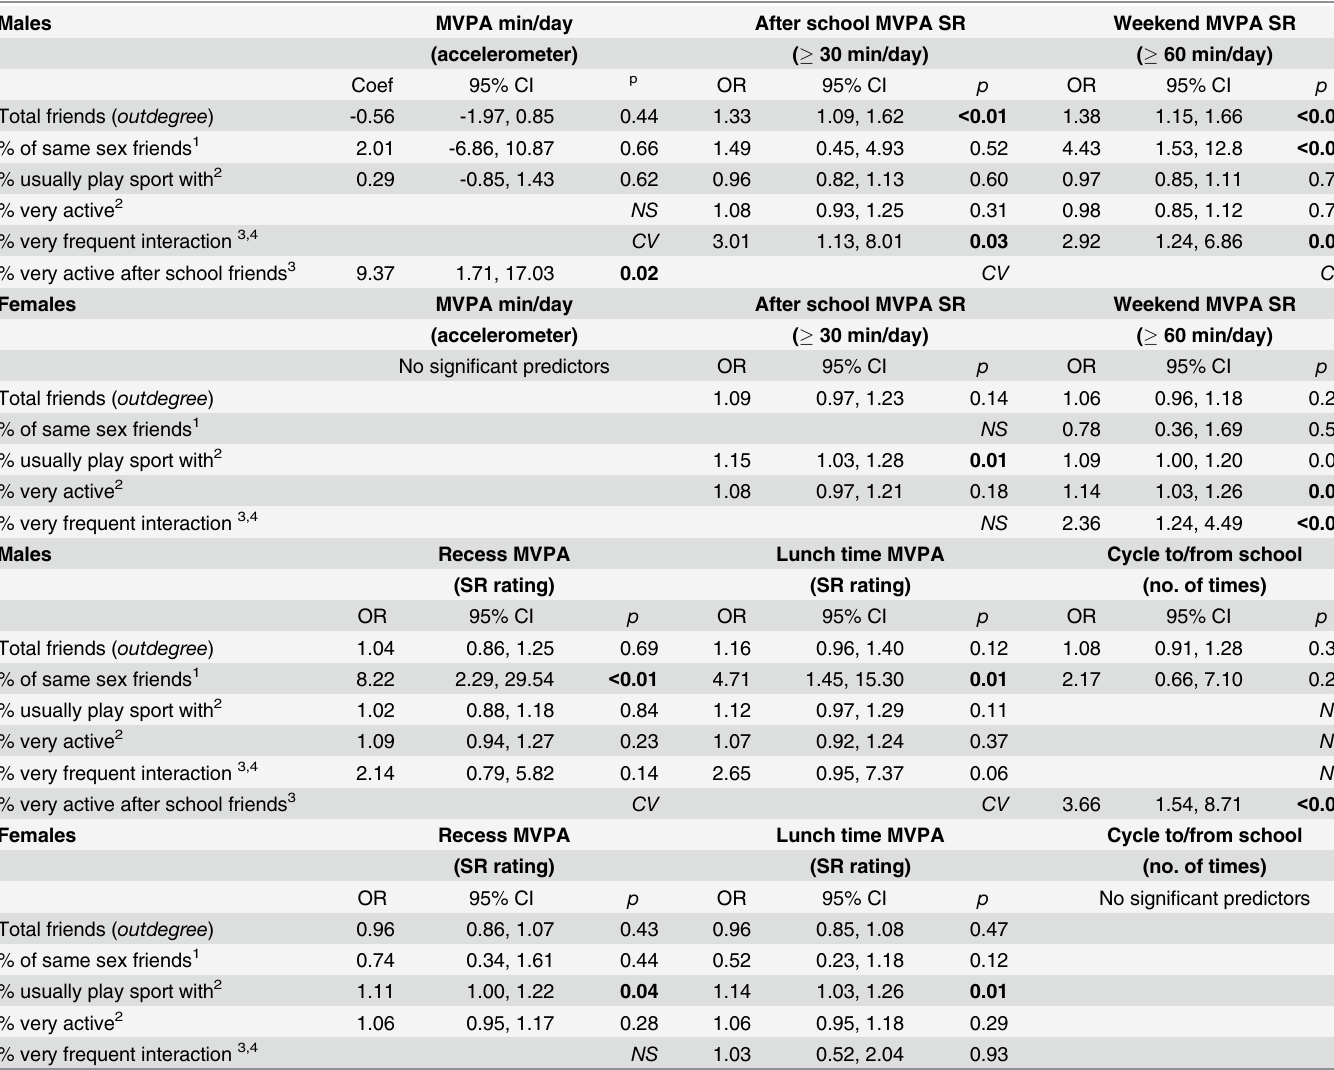
Table 3. Regression models for personal network characteristic predictors of PA for males and females.